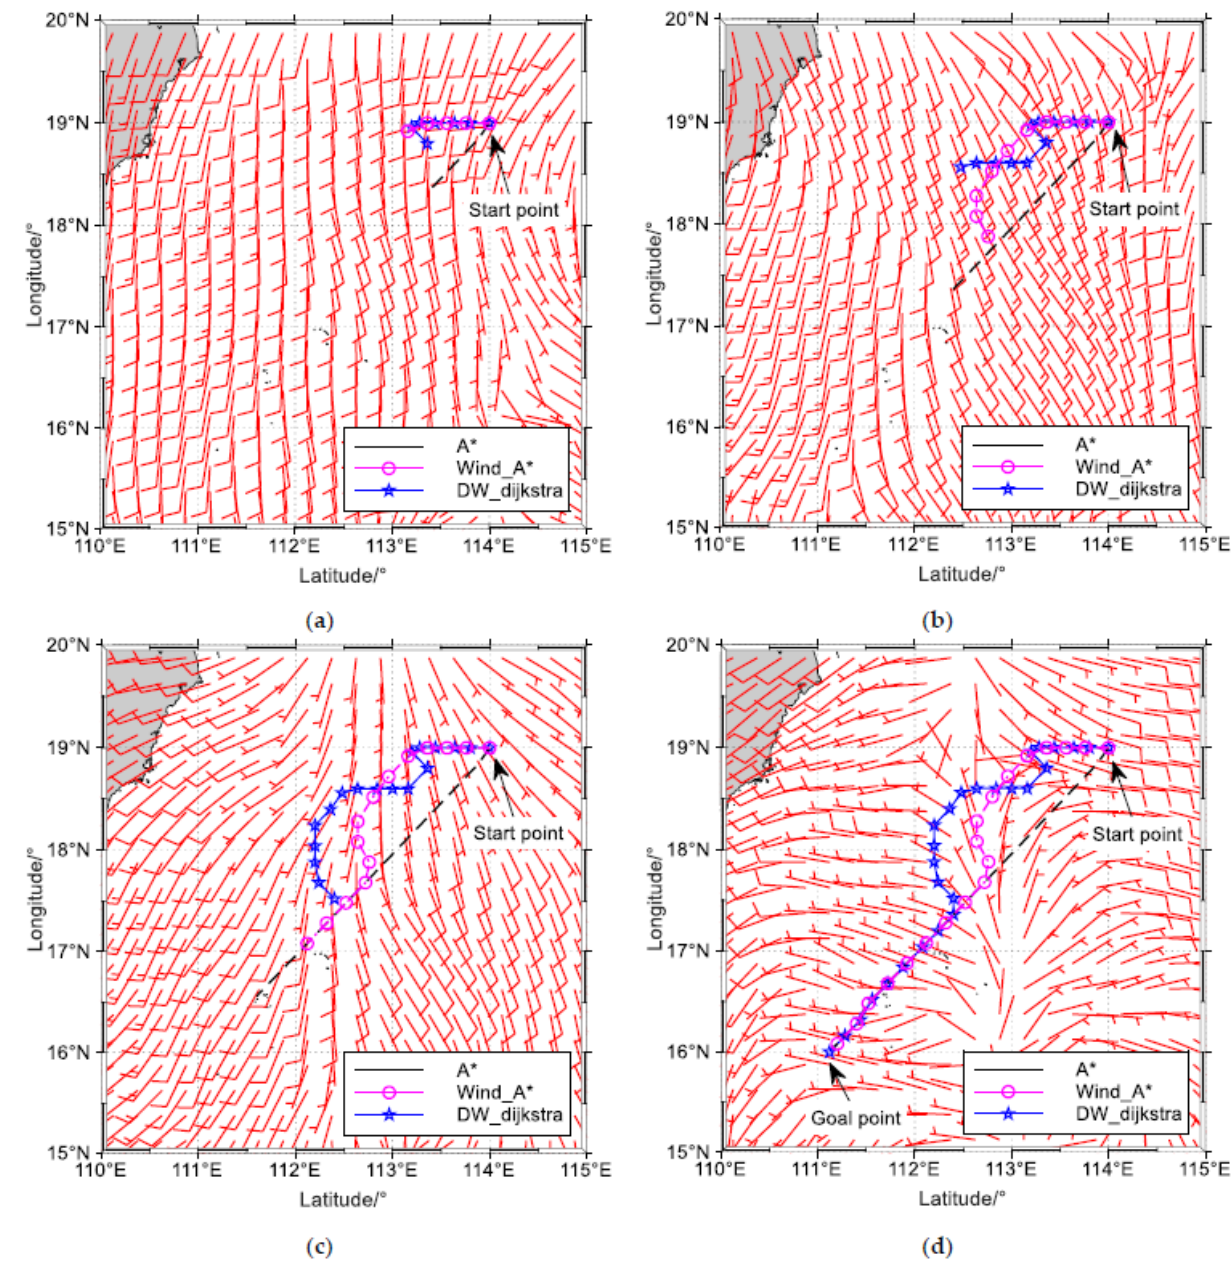
Figure 13. Comparison of three algorithm plan paths in a real wind field. ( a ) Path planed by different algorithms at 18:00 on 6 June 2021, ( b ) path planed by different algorithms at 18:00 on 7 June 2021, ( c ) path planed by different algorithms at 18:00 on 8 June 2021, and ( d ) path planed by different algorithms at 18:00 on 9 June 2021. Table 3. Comparison of energy consumption of three algorithms in a real wind field.